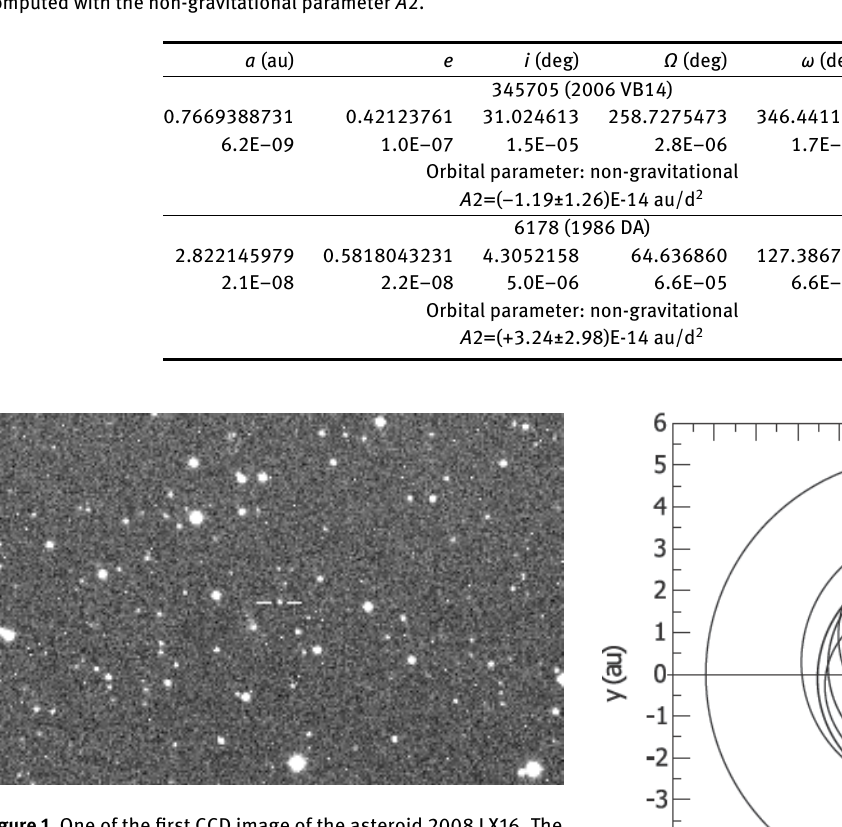
Table 4. Initial nominal orbital elements of the asteroids 345705 (2006 VB14) and 6178 (1986 DA): a denotes semimajor axis, e - eccentric- ity, angles i , Ω and ω refer to the Equinox J2000.0, M - mean anomaly. Epoch: JD2458800.5 TDB = 13 November 2019. Orbital elements are computed with the non-gravitational parameter A 2.